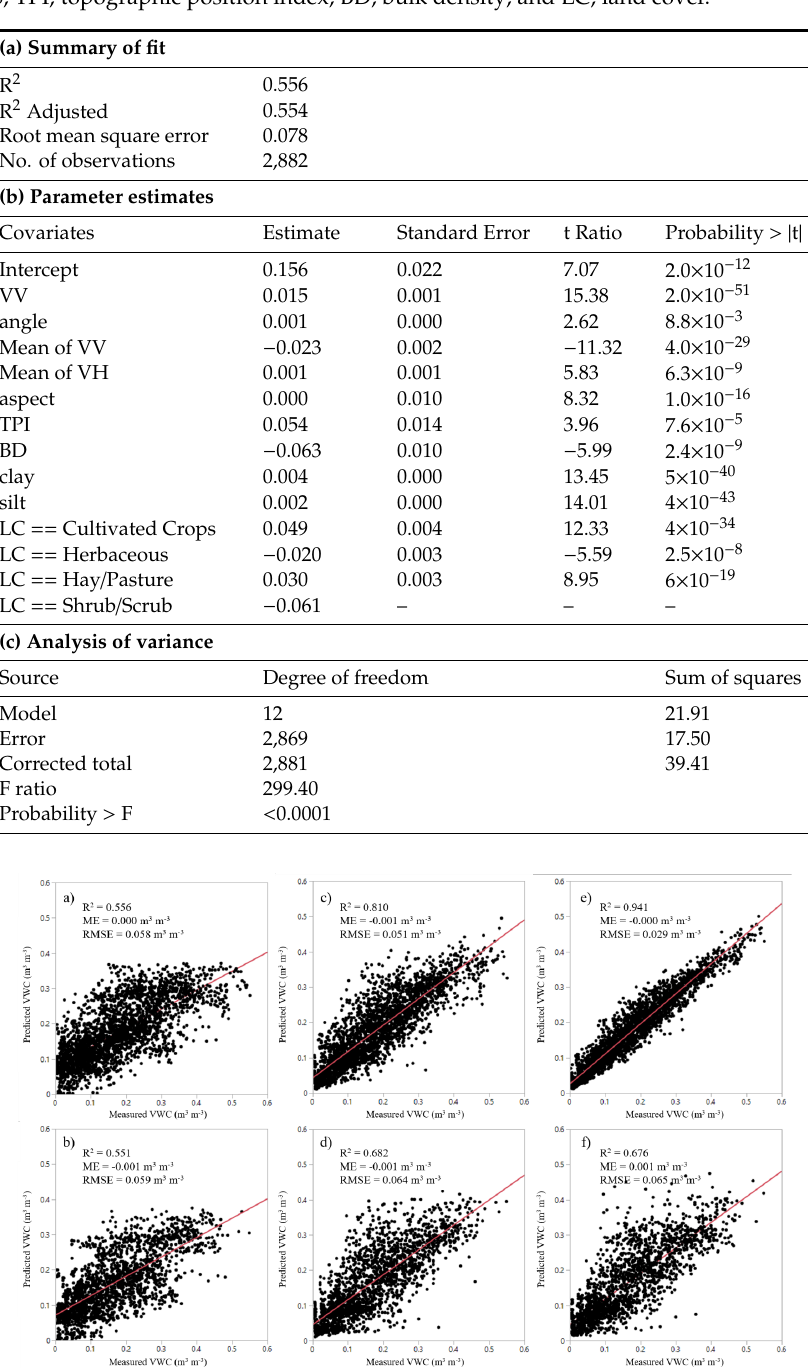
Table 2. Multiple linear regression (MLR) model for retrieving soil volumetric water content (VWC, m 3 m − 3 ) at 0–0.05 m depth. Note: coe ffi cient of determination, R 2 ; VH, backscatter in vertical